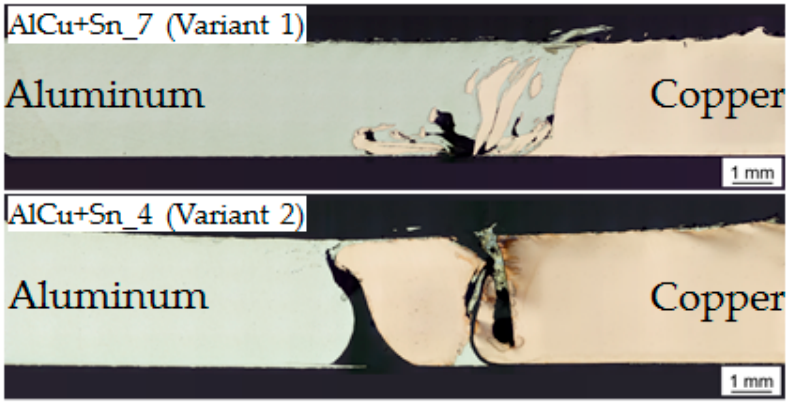
Figure 7 . Cross-sectional macrostructures for parameter combinations AlCu+Sn_7 (variant 1) and AlCu+Sn_4 (variant 2).